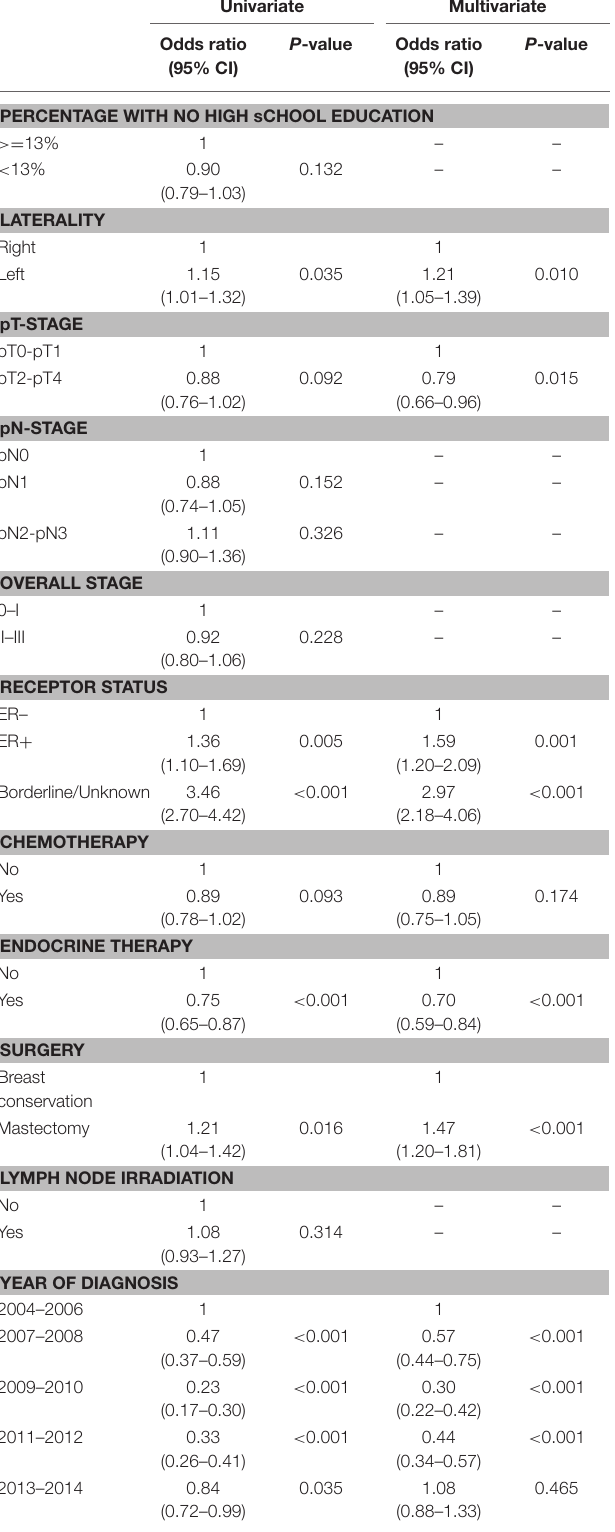
(LNI) ( p = 0.143). Supplemental Figures 1 – 5 illustrates the OS of PRT and EBRT for each of these subsets. Table 3 demonstrates MVA for OS for all patients and after including stratification criteria. On MVA, PRT no longer remained significant for OS within any of the stratified